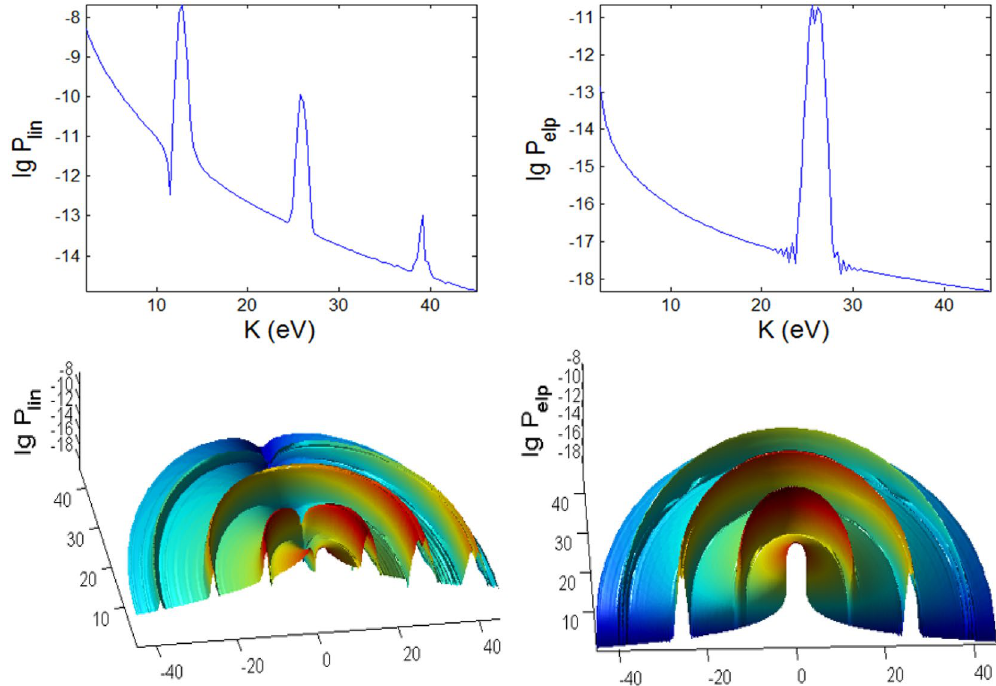
Figure 14. Same as Fig. 12 (photoionization probability for t p = 10 fs , versus Θ at Φ = 0 and K ) but for case C characterizing the MPI